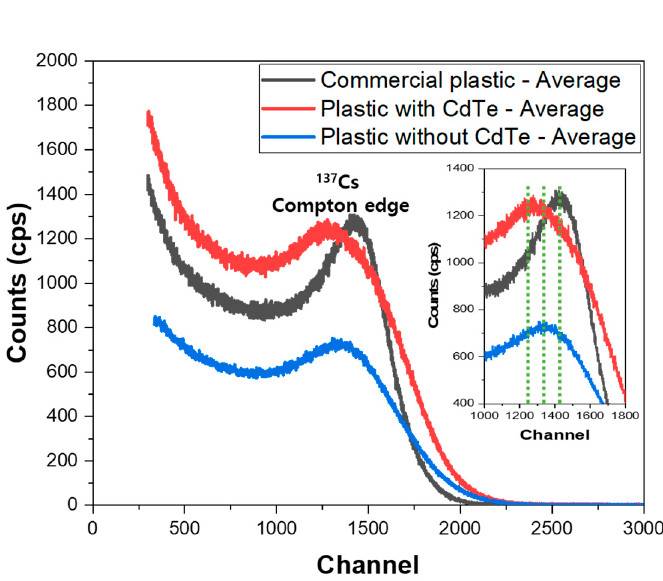
Figure 8. Gamma measurement spectrum of three plastic scintillators using Cs-137 point source. Insert figure represents relative counts from channel 1000 to 1800. Table 2. Compared relative efficiency for detection of radioactive cesium.